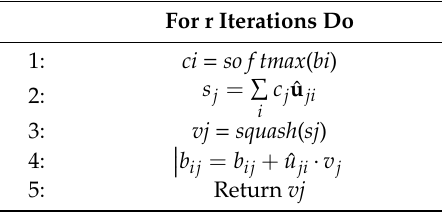
Table 3. Dynamic Routing